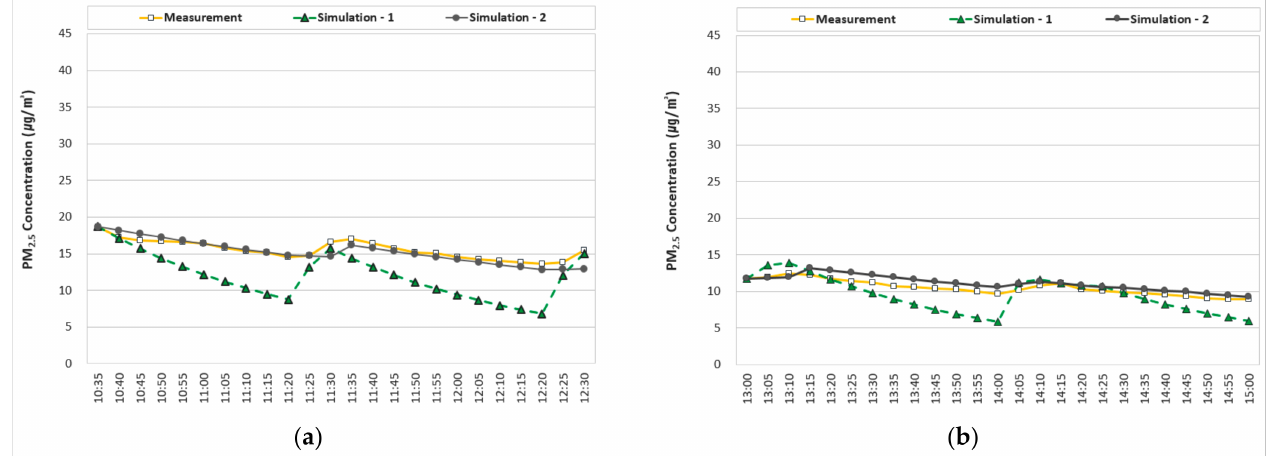
Figure 15. PM 2.5 data for a single-person office space on 15 February 2022. ( a ) Morning period. ( b ) Afternoon